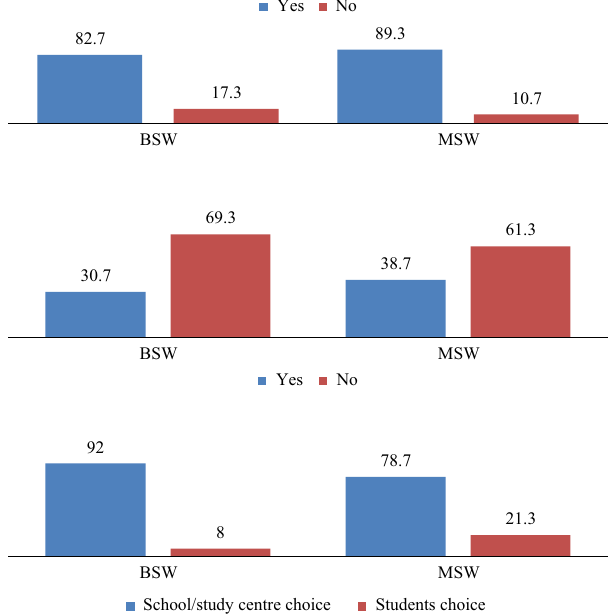
Figure 15. Basis of allotment of field